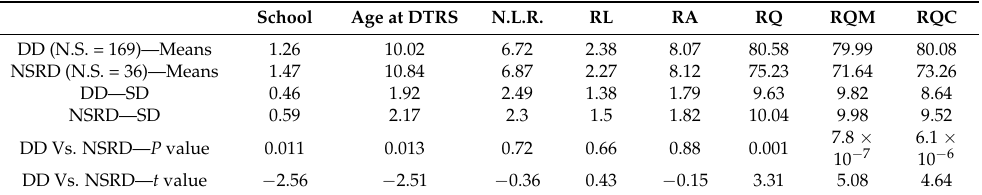
Table 2. Means, SD, t -test results of the reading test of DTRS in the two groups. DD =